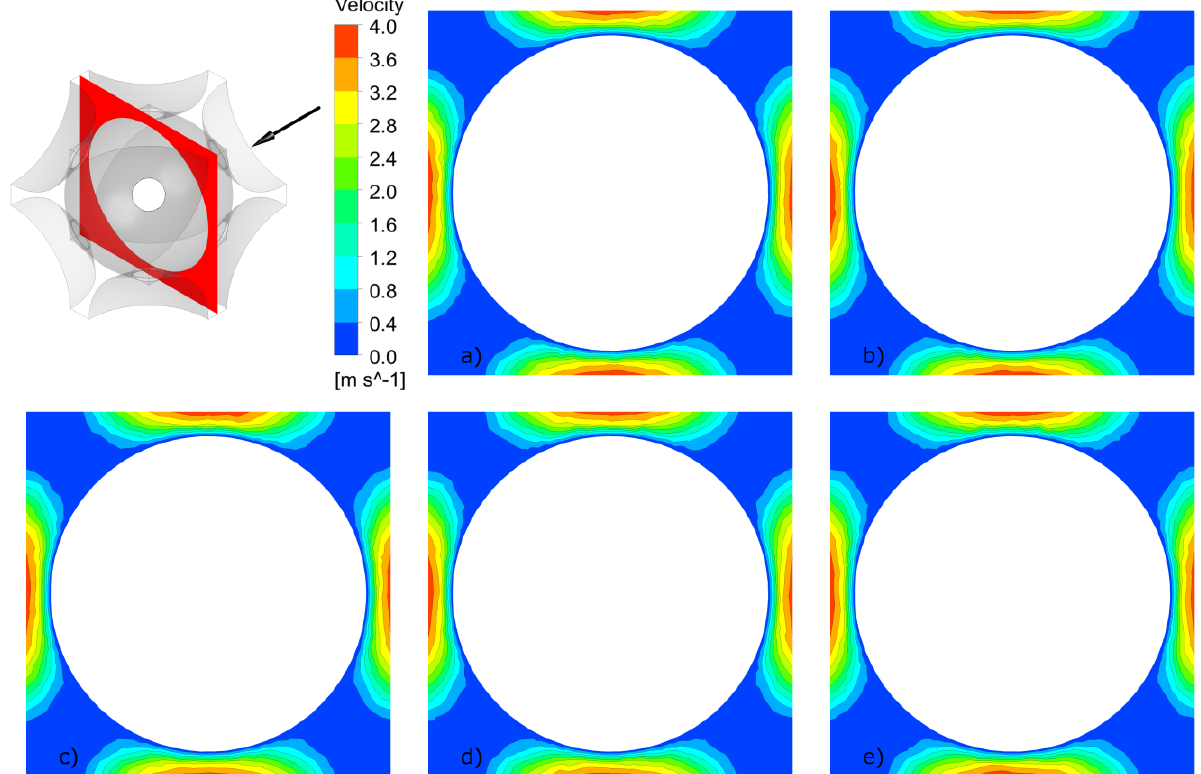
Fig. 11. Velocity magnitude on XY plane obtained with the discretization method with additional cylindrical volumes R cyl% equal: a – 5.00%. b – 6.25%. c – 7.50%. d – 8.75%. e - 20.00%.